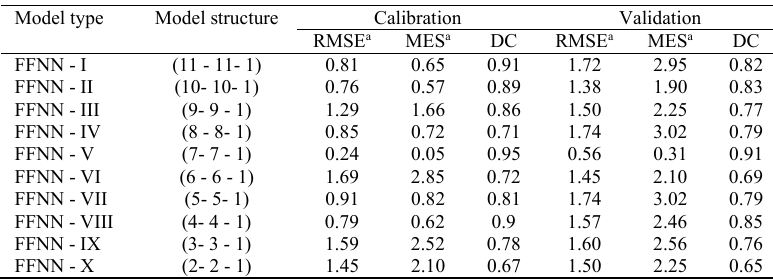
Table 4: Performance evaluation result for FFNN model